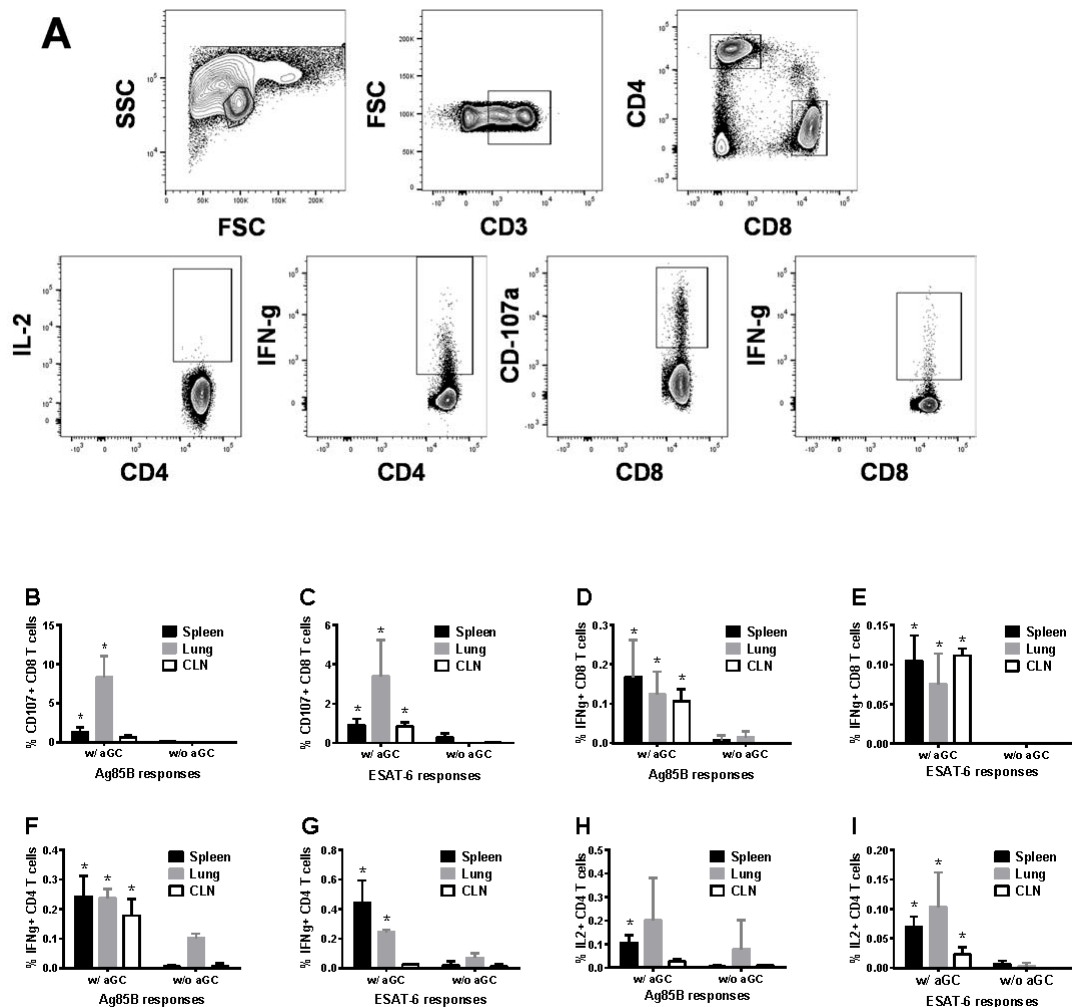
Figure 2. Sublingual immunization with Mtb proteins Ag85B and ESAT-6 in the presence of α -GalCer adjuvant induces CD4 and CD8 T cell responses. C57BL/6 female mice were immunized as in Figure 1 and cells isolated from lung, spleen and cervical lymph node(CLN) were analyzed by intracellular cytokine flow cytometry for CD8 and CD4 T cell responses specific to the Mtb proteins Ag85B and ESAT-6. Flow cytometry gating strategy for detecting the different lymphocyte subsets expressing the cytokines analyzed (panel ( A )). Data for the CD8 T cells positive for CD107a and IFN- γ (panels ( B – E )), and CD4 T cell for IFN- γ and IL2 (panels ( F – I )). Significant responses (*, p < 0.05) between groups vaccinated in the presence and absence of α -GalCer (w/aGC and w/o aGC, respectively) were noted. The experiment was performed using 5 mice/group and repeated 2 times.